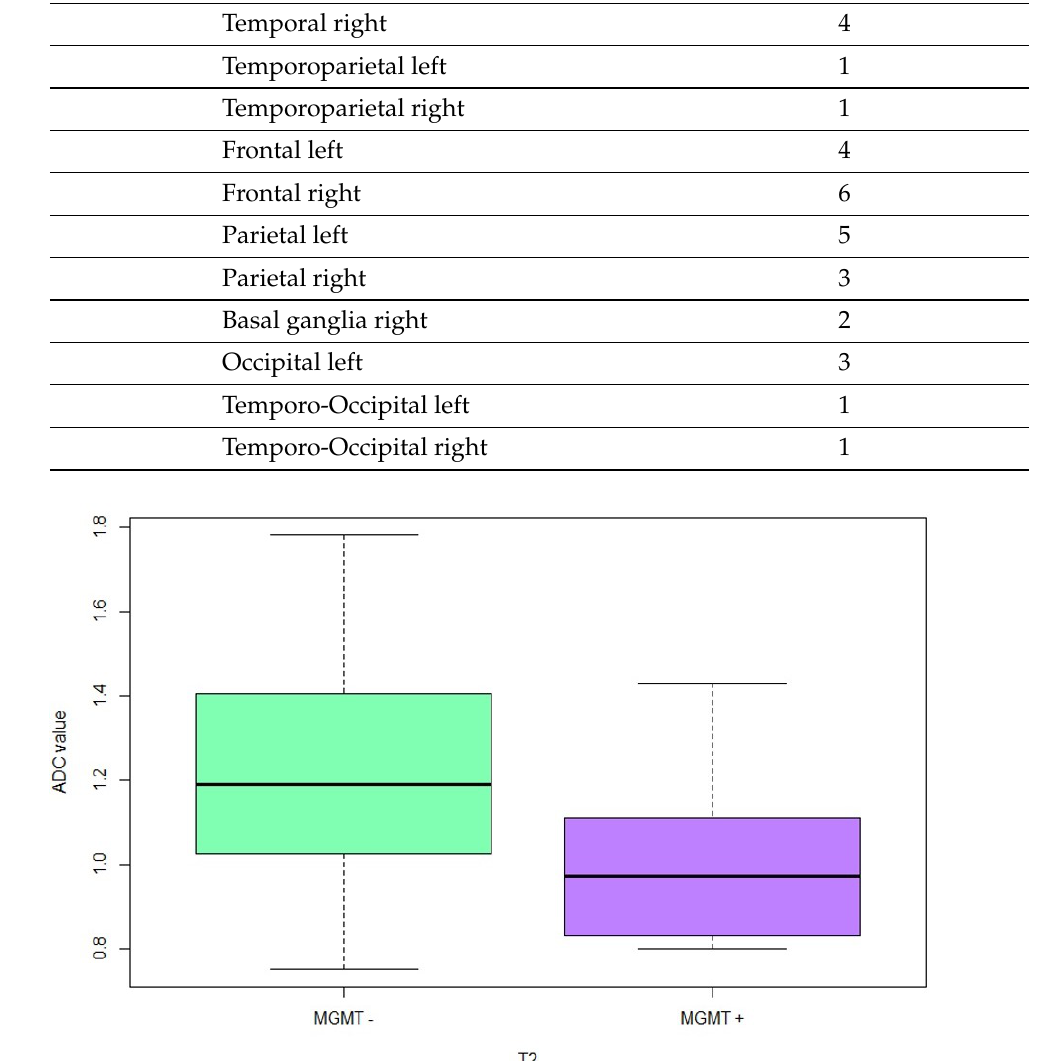
Figure 2. Absolute ADC values in peritumoral white matter (ROI 3) in patients with MGMT- unmethylated GB (MGMT − ) and patients with MGMT-methylated GB (MGMT